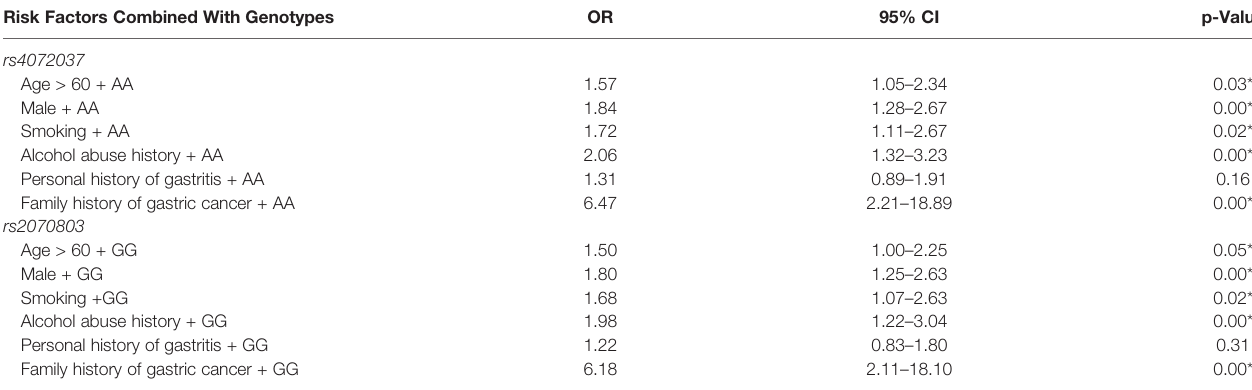
TABLE 6 | Association of the genotypes of two SNPs combined with environmental factors with the risk of gastric cancer: multivariate logistic regression analysis. Risk Factors Combined With Genotypes OR 95% CI p-Value rs4072037 Age > 60 +